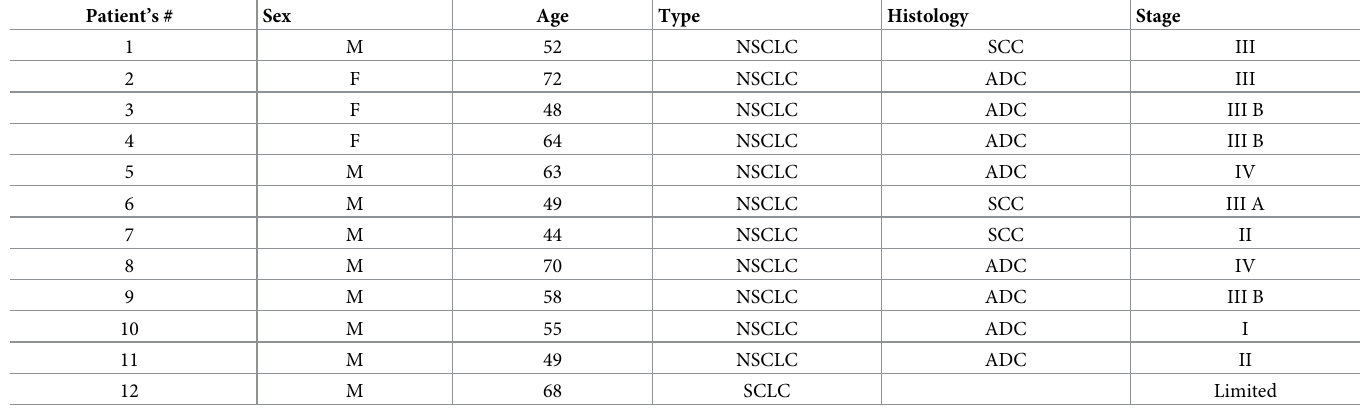
Table 1. Patients’ cohort and tumor types used in enzymatic and conformational studies of their ACEs. Patient’s